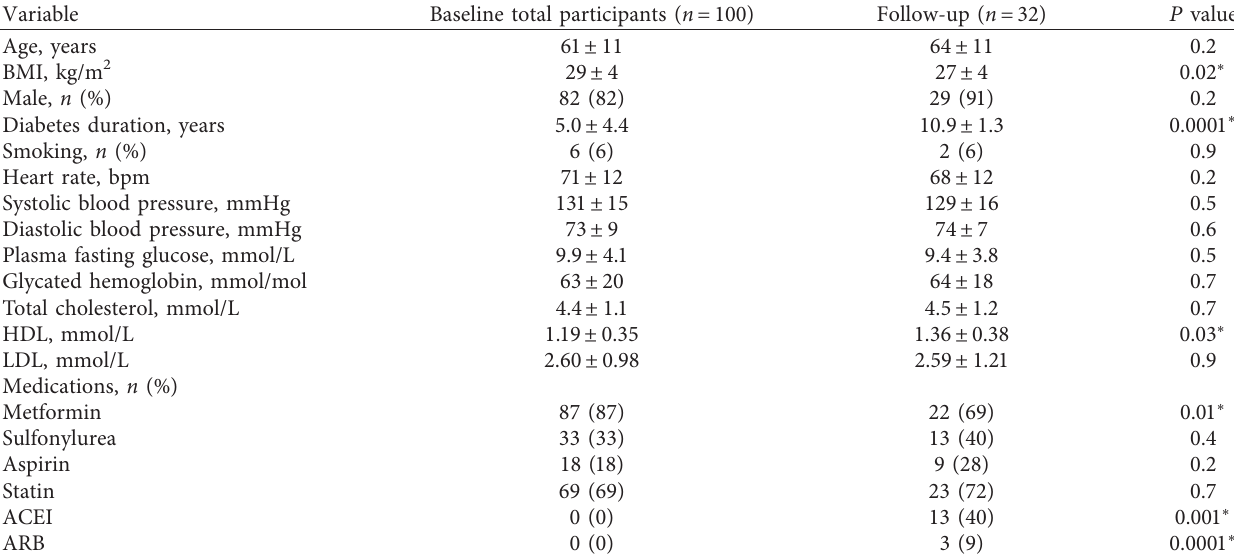
Table 1: Clinical and biochemical